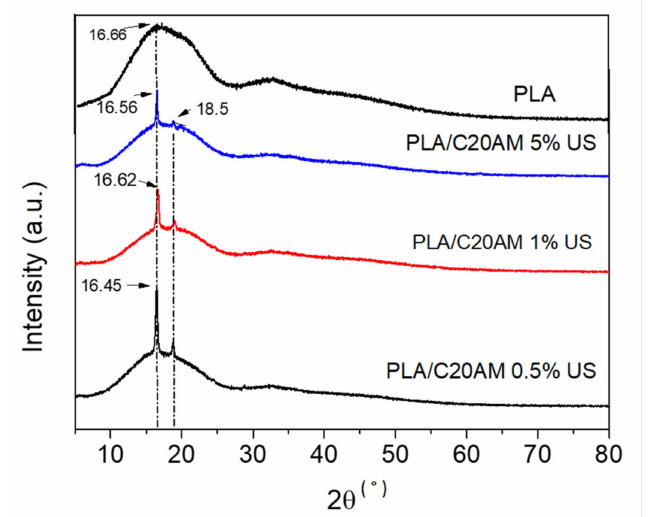
Figure 7. X–ray diffraction patterns of PLA and samples containing 0.5, 1, and 5% of C20A modified. In addition, in nanocomposites, a signal associated with the crystals of the PLA homopolymer becomes visible at 18.5 ◦ , as reported by Sajjad Saeidlou et al. in 2012, who studied the formation of stereocomplexes between poly (L-lactic acid) and poly (D- lactic acid) in the molten state [49]. These signals at 16 and 18.5 ◦ that protrude in